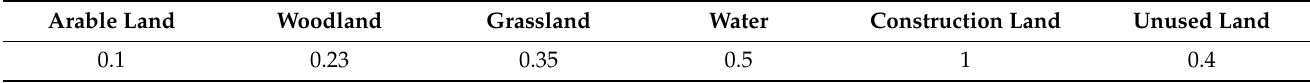
Table 2. Neighborhood weight.